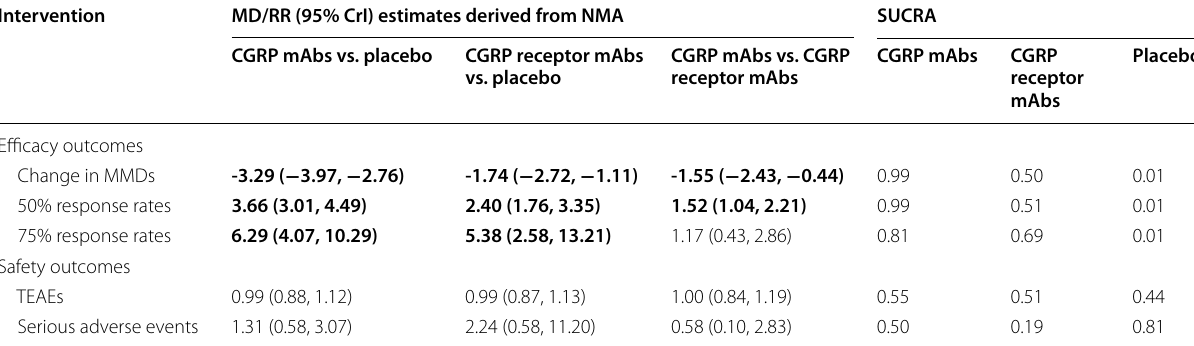
Table 2 Pooled MD/RR and relative CrI derived from three-node network meta-analysis with different treatment regimens in migraine patients with previous preventive treatment